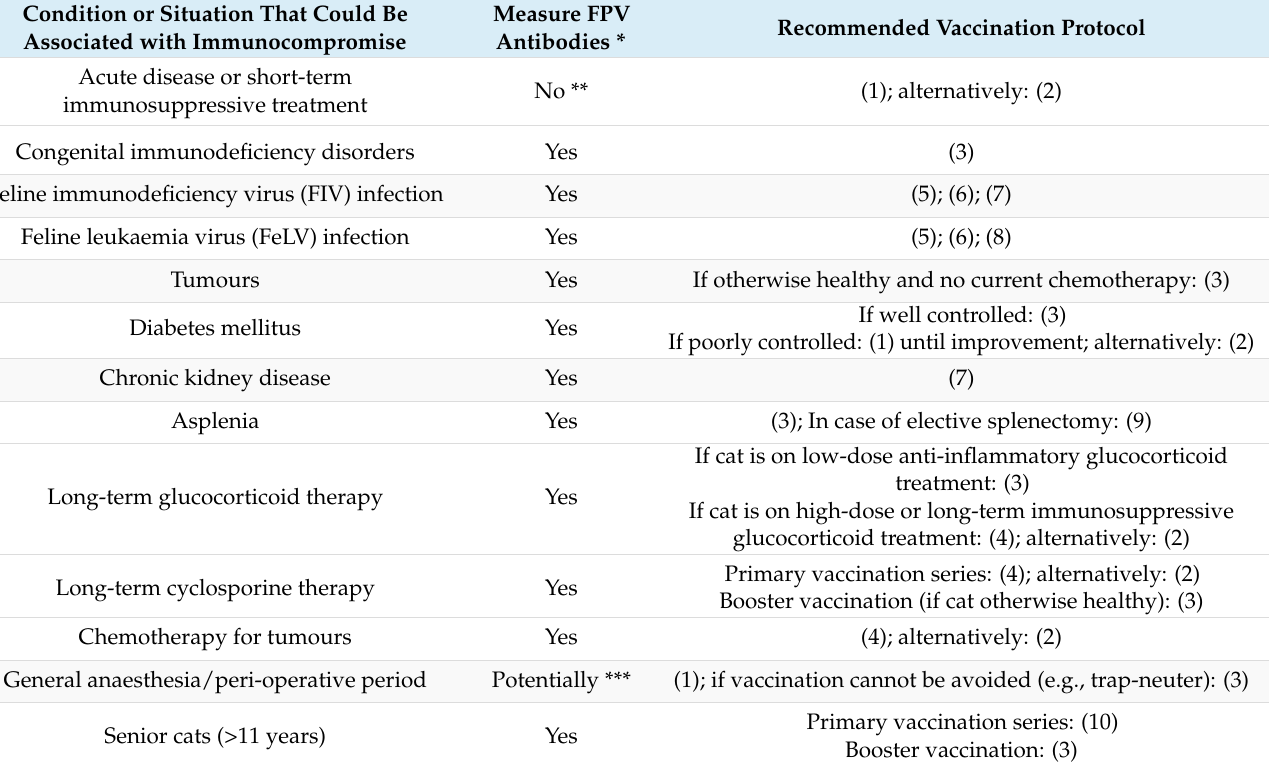
Table 1. Vaccination recommendations in immunocompromised